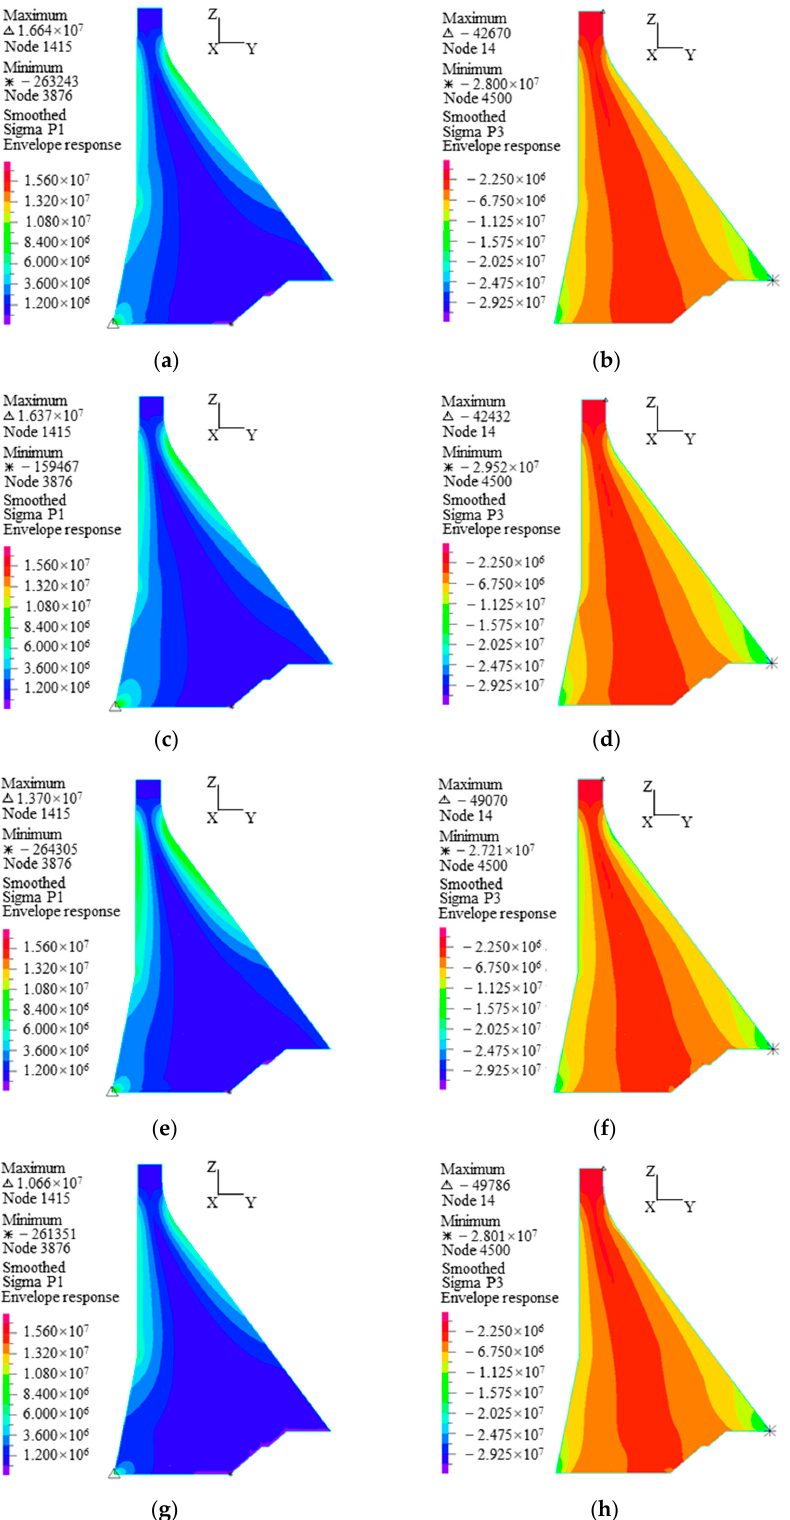
Figure 10. The principal stress envelopes of the dam for different foundation sizes obtained using the MLF model (Pa). ( a ) The distribution of σ 1 for B-1 (1H), ( b ) the distribution of σ 3 for B-1 (1H), ( c ) the distribution of σ 1 for B-2 (1.5H), ( d ) the distribution of σ 3 for B-2 (1.5H), ( e ) the distribution of σ 1 for B-3 (2H), ( f ) the distribution of σ 3 for B-3 (2H), ( g ) the distribution of σ 1 for B-4 (3H), ( h ) the distribution of σ 3 for B-4 (3H). σ σ σ 1 for B-3 (2H), ( f ) the distribution of 3 for B-3 (2H), ( g ) the distribution of 1 for B-4 (3H), ( h )